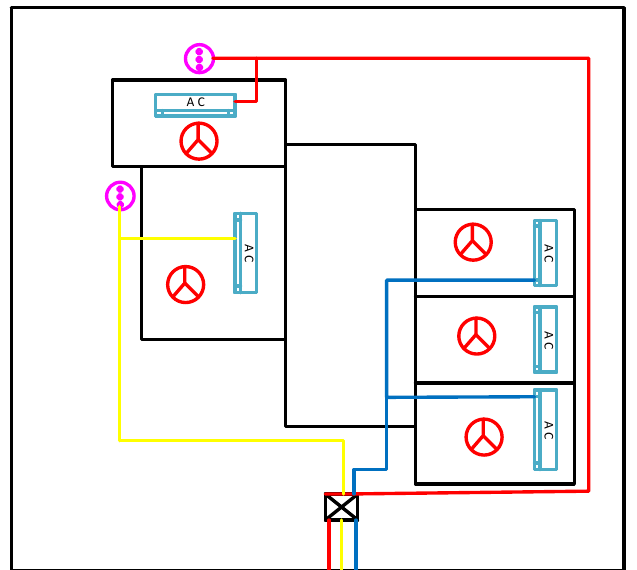
Figure 19. Proposed model for the coordinator house.